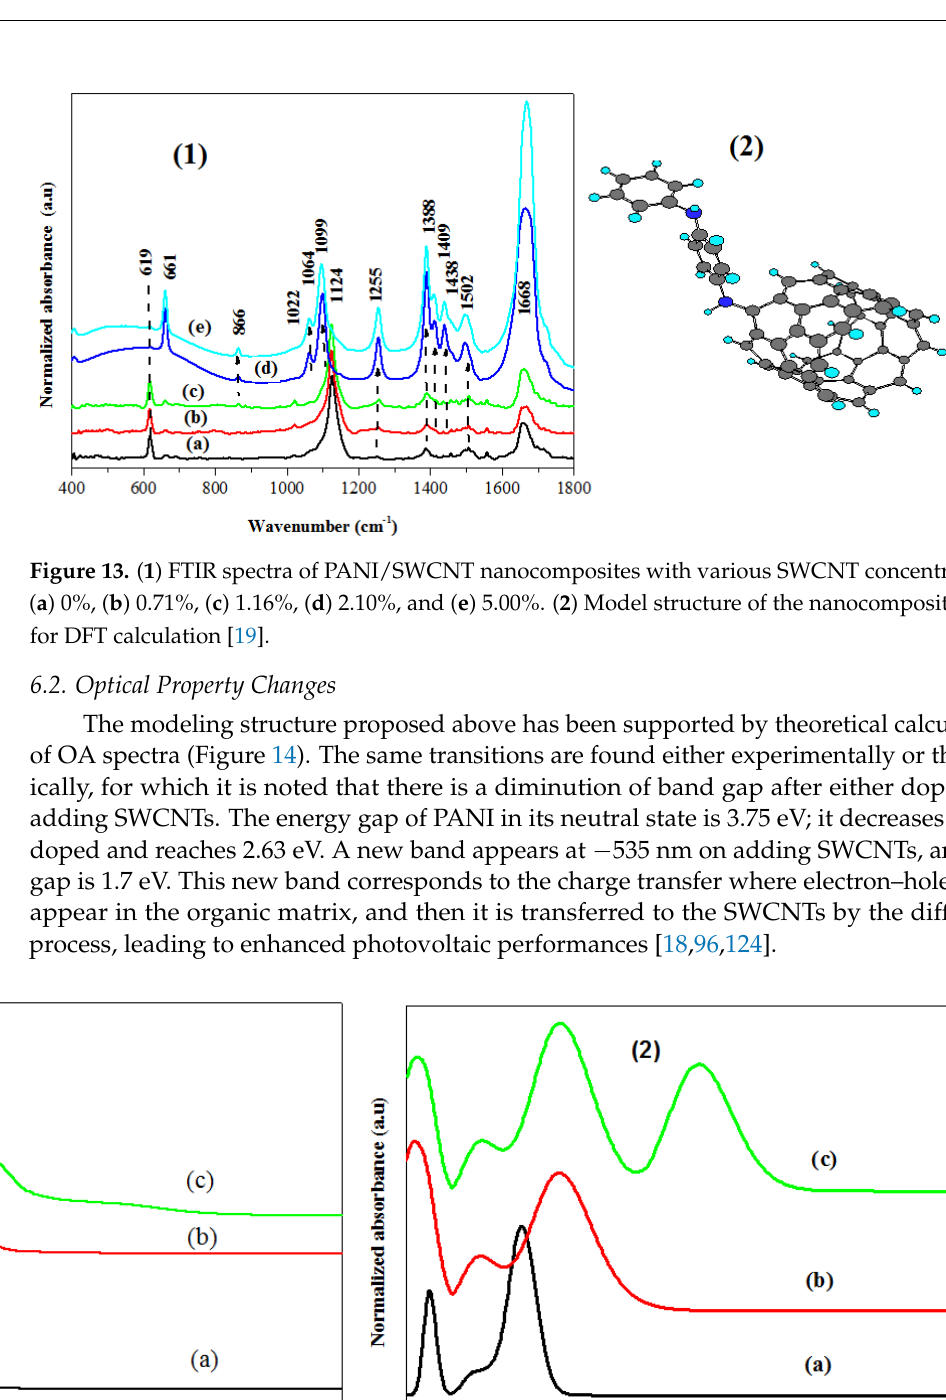
Figure 15. ( 1 ) HOMO and LUMO orbitals: doped PANI ( a ) and nanocomposite ( b ). ( 2 ) Effect of chain length on the HOMO–LUMO energy levels of PANI in pristine and doped states. The ability of the resulting material to improve photovoltaic conversion is checked from its electronic structure (Figure 15(2)). Indeed, HOMO–LUMO energy levels are calculated from the optimization of model structures of pristine and doped states for different chain lengths [127]. The HOMO–LUMO energy levels for an infinite chain length can, therefore, be evi- denced following Aleman et al. [127], where the theoretical energy gaps are 3.58 and 2.31 eV, respectively, for neutral and doped states. Other parameters can be evaluated, such as the PCE and the open-circuit voltage (V OC ). From the individual theoretical electronic structures (donor and acceptor), PCE can be evaluated using the Scharber diagram. 0.0